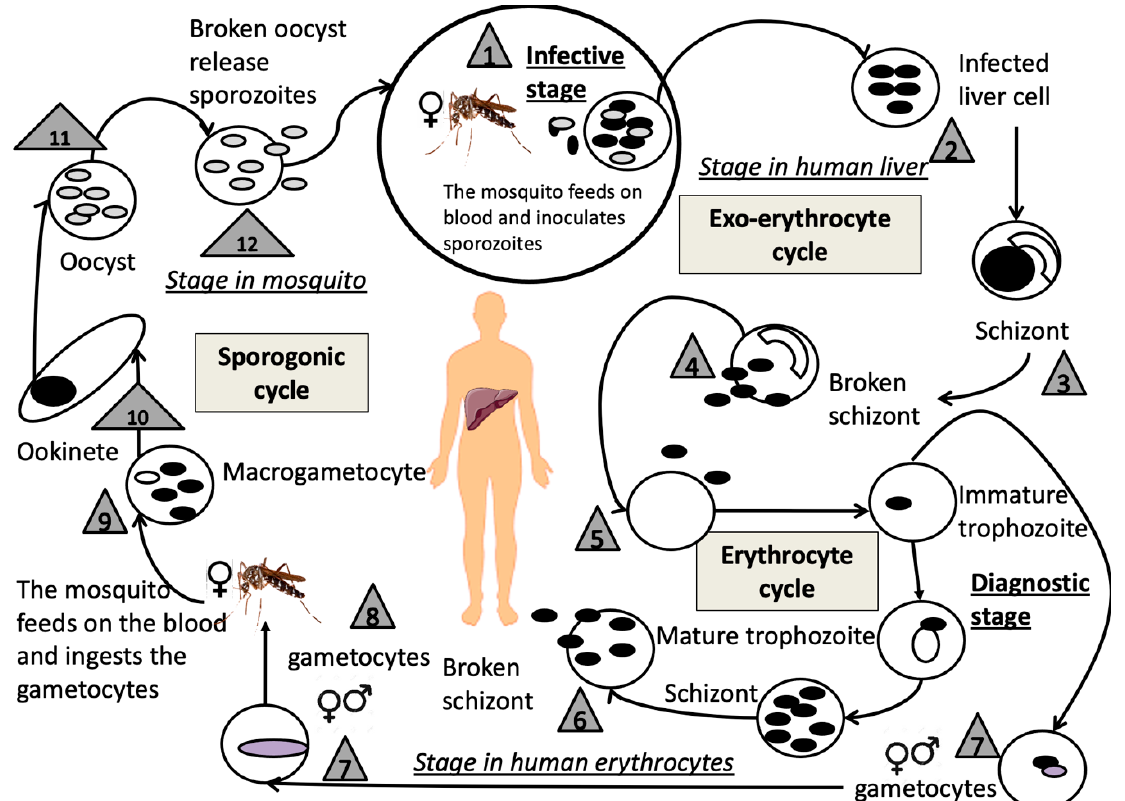
Figure 5. Replication stages in malaria infection. The sporozoites enter the circulation after the mosquito’s bite. They are then transported through the blood to hepatocytes in the liver, initiating the exo-red cell cycle. There, they rapidly multiply within hepatocytes by multiple cycles of asexual division and transform into merozoites that enter the bloodstream and leave the liver. Merozoites invade red blood cells, initiating the erythrocytic cycle. As the nucleus begins to divide, the trophozoite is now called a developing schizont. The mature schizont contains merozoites that are released into the blood- stream. Although many merozoites are destroyed by the immune system, others immediately invade red blood cells, in which a new cycle of erythrocytic schizogony begins. After several generations of erythrocytes, male and female gameto- cytes develop from some merozoites (sexual cycle). With the union of the gametes, the egg is generated in the mosquito’s